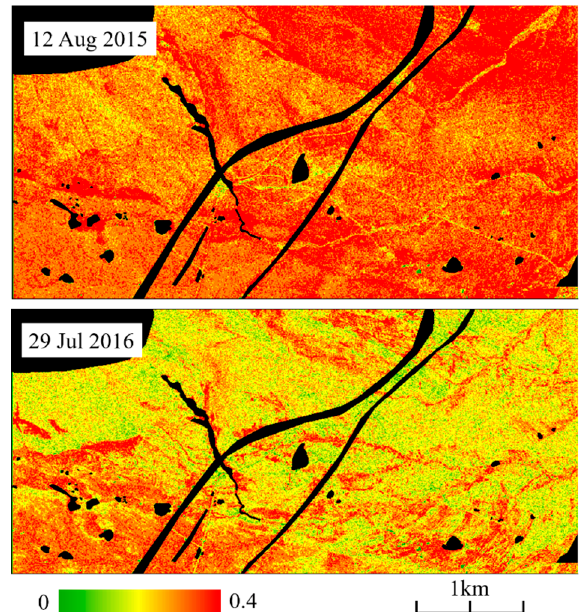
Figure 9. SM, in cm 3 /cm 3 retrieved using the time series approach on 12 August 2015 and 29 July 2016. Black areas are masks of open water, railway, and highway.